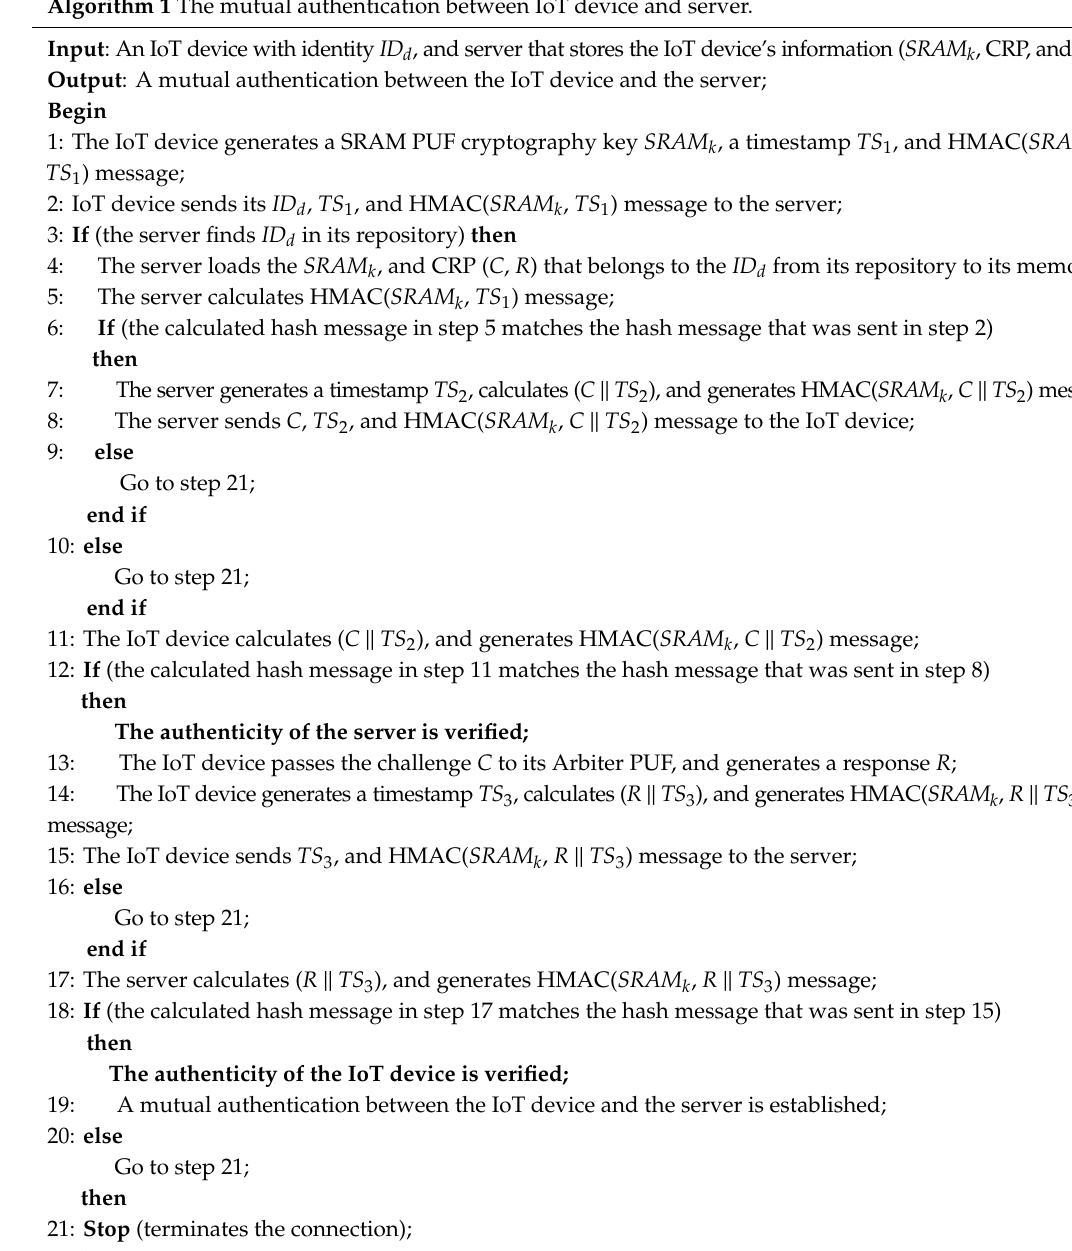
Algorithm 1 The mutual authentication between IoT device and